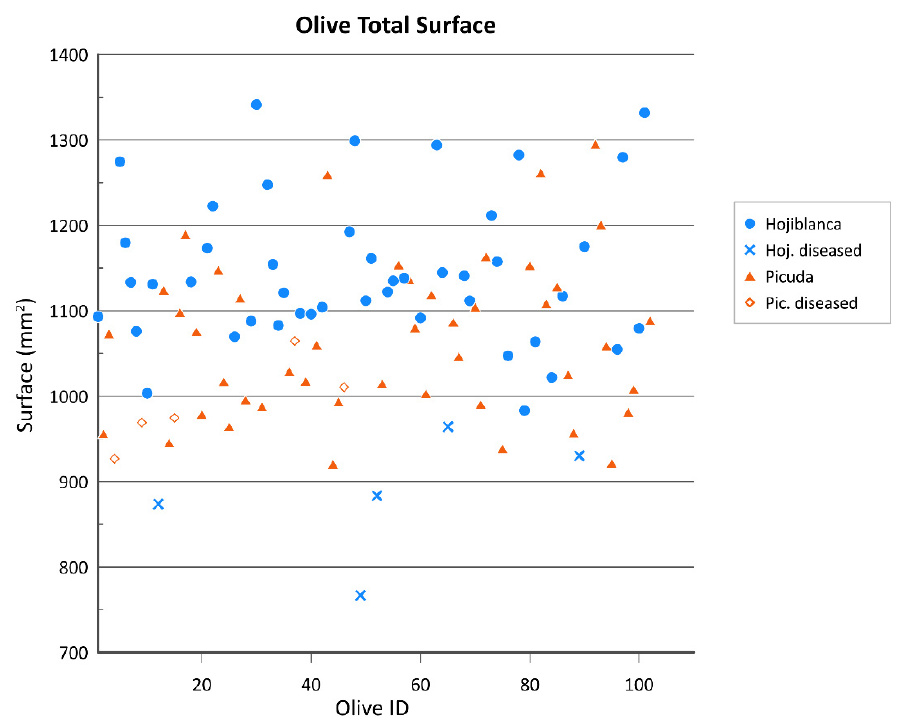
Figure 22. Total Area from 3D plot.